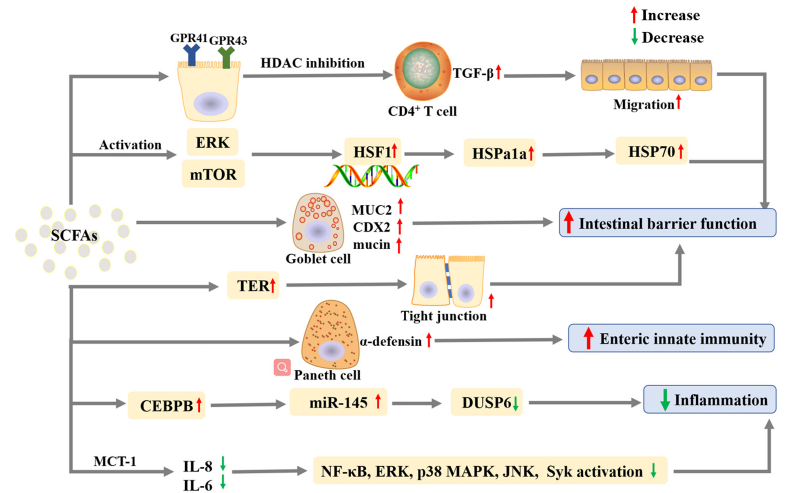
Figure 4. The main effects and mechanisms of SCFAs on inflammatory bowel diseases. Abbrevia- tion: CEBPB, CCAAT enhancer-binding protein beta; DUSP6, dual-specificity phosphatase 6; ERK, extracellular signal-regulated kinase; GRP, G-protein receptor; HDAC, histone deacetylase; HSF, heat shock factor; HSP, heat shock proteins; IL, interleukin; JNK, c-Jun N-terminal kinase; MAPK, p38 mitogen-activated protein kinase; MCT-1, monocarboxylate transporter 1; miR-145, microRNA- 145; mTOR, mechanistic target of rapamycin; NF- κ B, nuclear factor-kappa B; SCFAs, short-chain fatty acid; Syk, spleen tyrosine kinase; TGF- β , transforming growth factor- β .